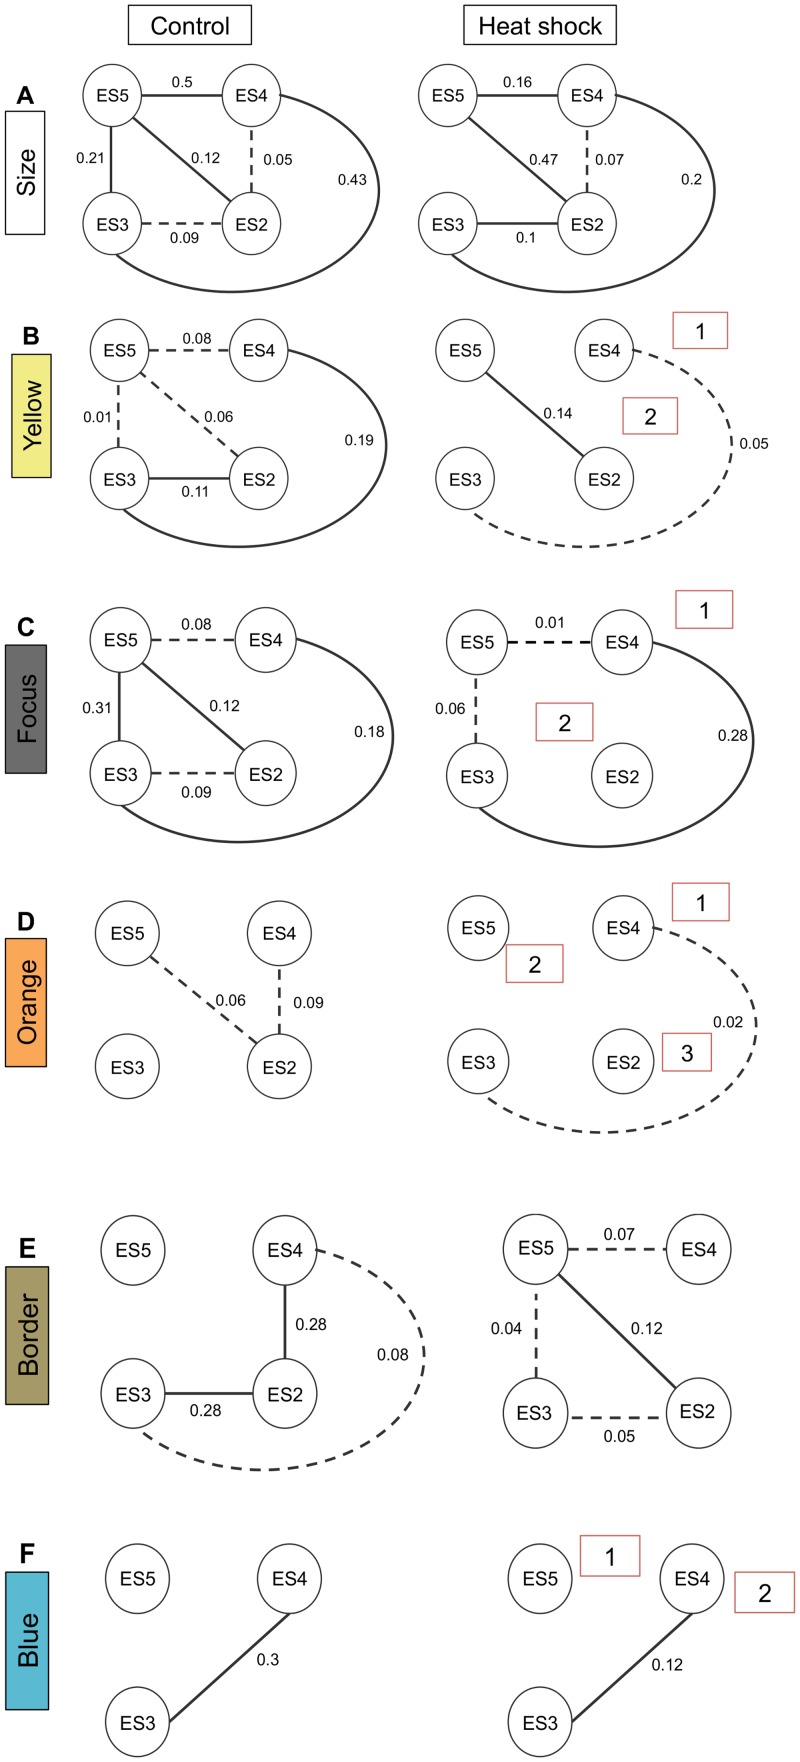
Comparison of phenotypic correlations within and between control and heat shock groups for eyespot size and pigment rings.Edges infer integration among eyespots based on edge exclusion deviance values above the critical value from the χ2 distribution. Eyespots without edges are conditionally independent from all other eyespots, χ2 <3.84, p<0.05. Edge strength values represent the strength of integration between eyespots [32]. Heat shock results in a doubling of independent modules (shown by red numbered boxes). Solid and broken lines represent strong and weak integration respectively.